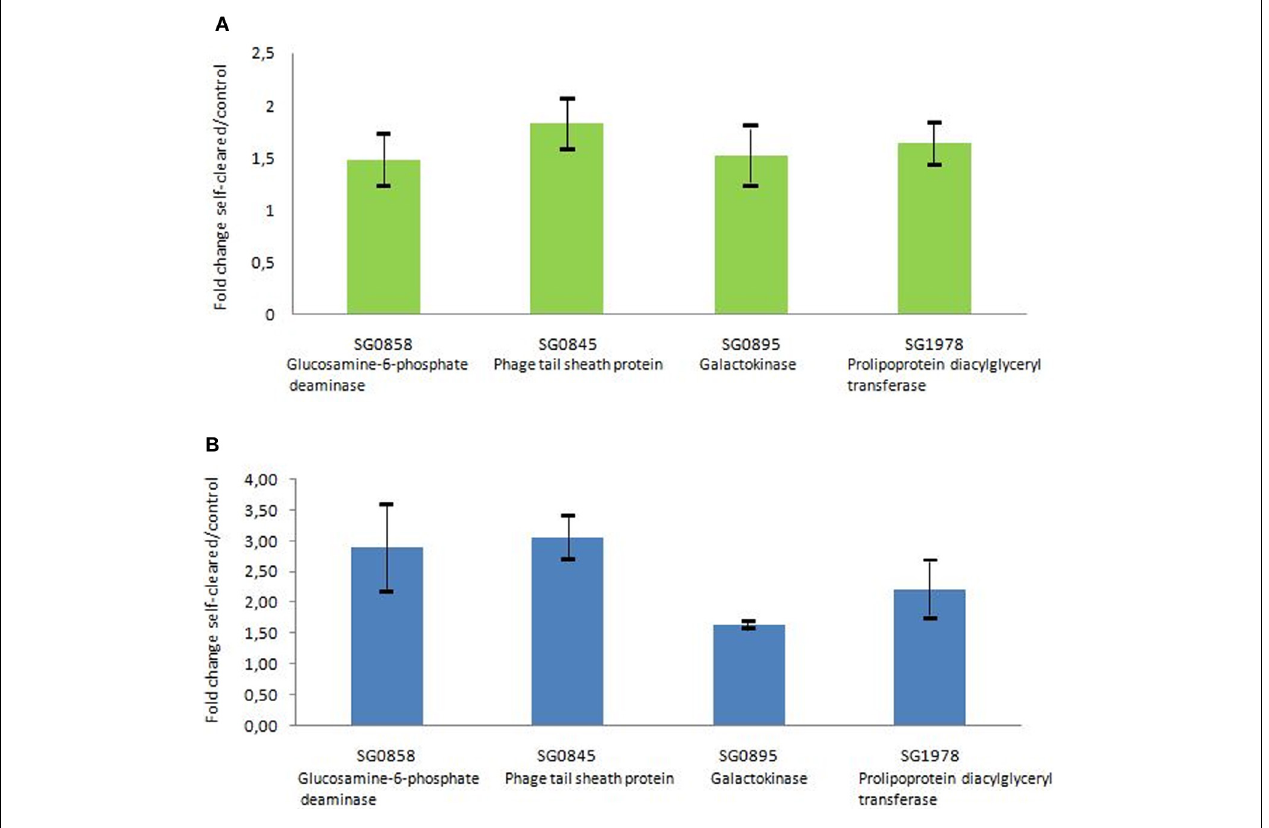
FIGURE 2 | Comparison of selected gene expression assessed by quantitative PCR and by microarray technologies. (A) Gene expression was assessed by microarray technology. The n-fold change value was calculated on the basis of normalized data when comparing the level of gene expression from S. glossinidius derived from self-cured flies with those of control flies fed on a non-infected blood meal. Error bar represents the